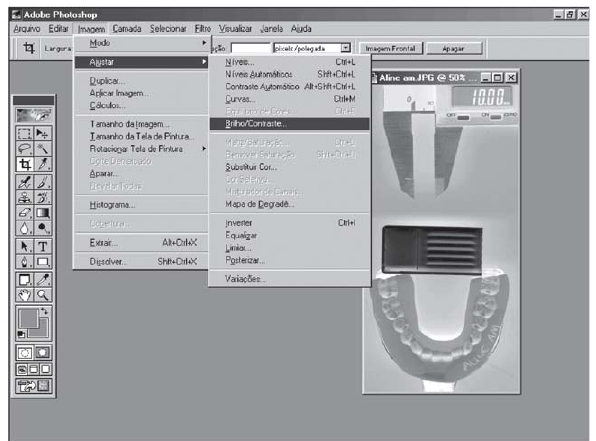
FIGURE 1- Image processing in the Adobe Photoshop ® 4.0 software: Inversion, grey scale, and adjustment of contrast and brightness